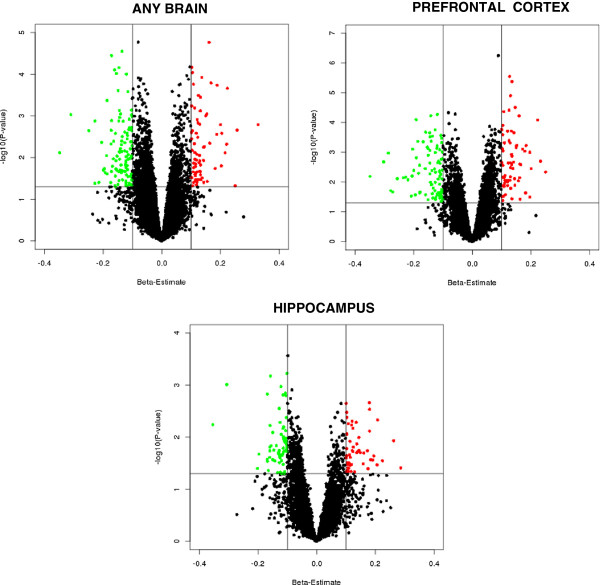
Volcano plots showing effect size estimates by significance of each gene for the three mega-analyses. Effect sizes captured as log2(FC) are shown on the X-axis, and significance levels measured as –log10(p-value) are shown on the Y-axis. Each dot represents an individual gene. Red dots represent significantly up-regulated genes with log2(FC) > 0.1 (FC > 1.07) at p-value < 0.05, while green dots represent significantly down-regulated genes with log2(FC) < -0.1 (FC < -1.07) at p-value < 0.05.